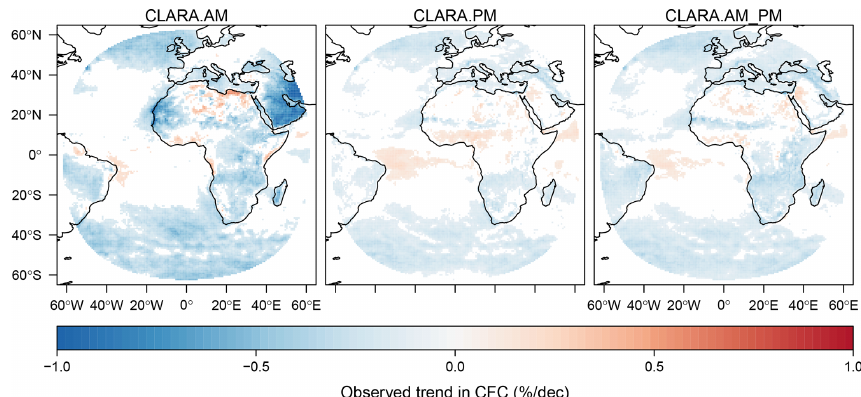
Figure 16. Observed trends in the CLARA-A2 CFC CDR derived from morning (AM), afternoon (PM), and combined (AM_PM) satellites. Only statistically significant trends are